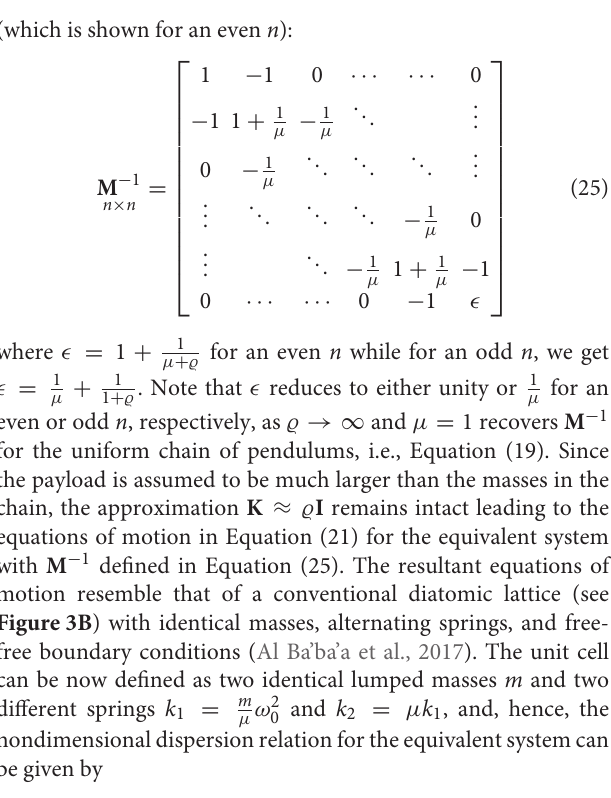
FIGURE 2 | Frequency response diagrams and corresponding pole distribution for (A) ̺ Numerical dispersion contours constructed from the actual chain of pendulums ( n obtained from the equivalent system via Equation (22). (Spectral and transient properties of the excitation are provided for